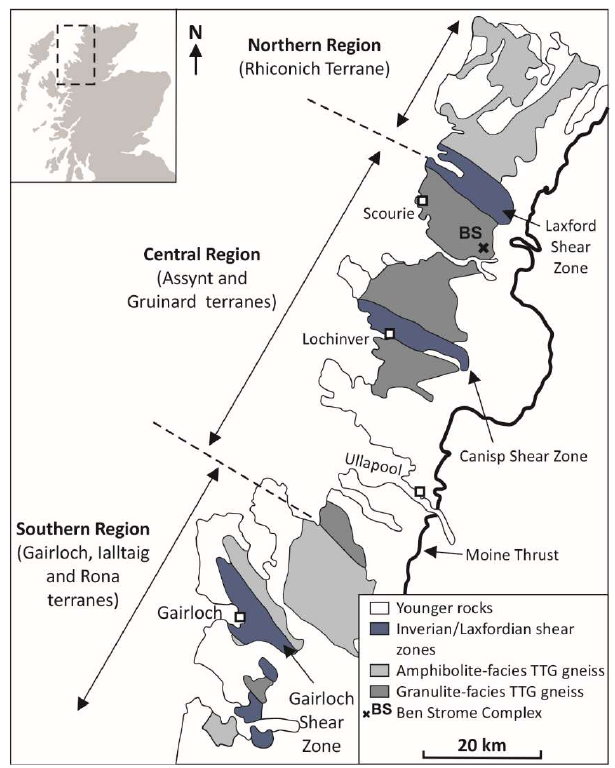
Figure 2. Simplified geological map of the Lewisian Gneiss Complex (LGC), including the location of the Ben Strome Complex. Redrawn after: [45,51,54,76]. Inset: location of the LGC in Scotland.